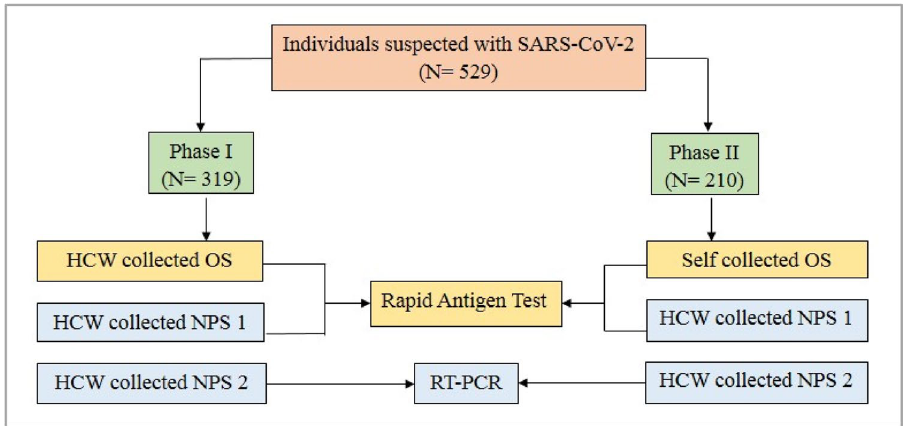
Figure 1. Work flow for the Study. HCW: Health Care Worker; OS: Oral Swab; NPS: Nasopharyngeal